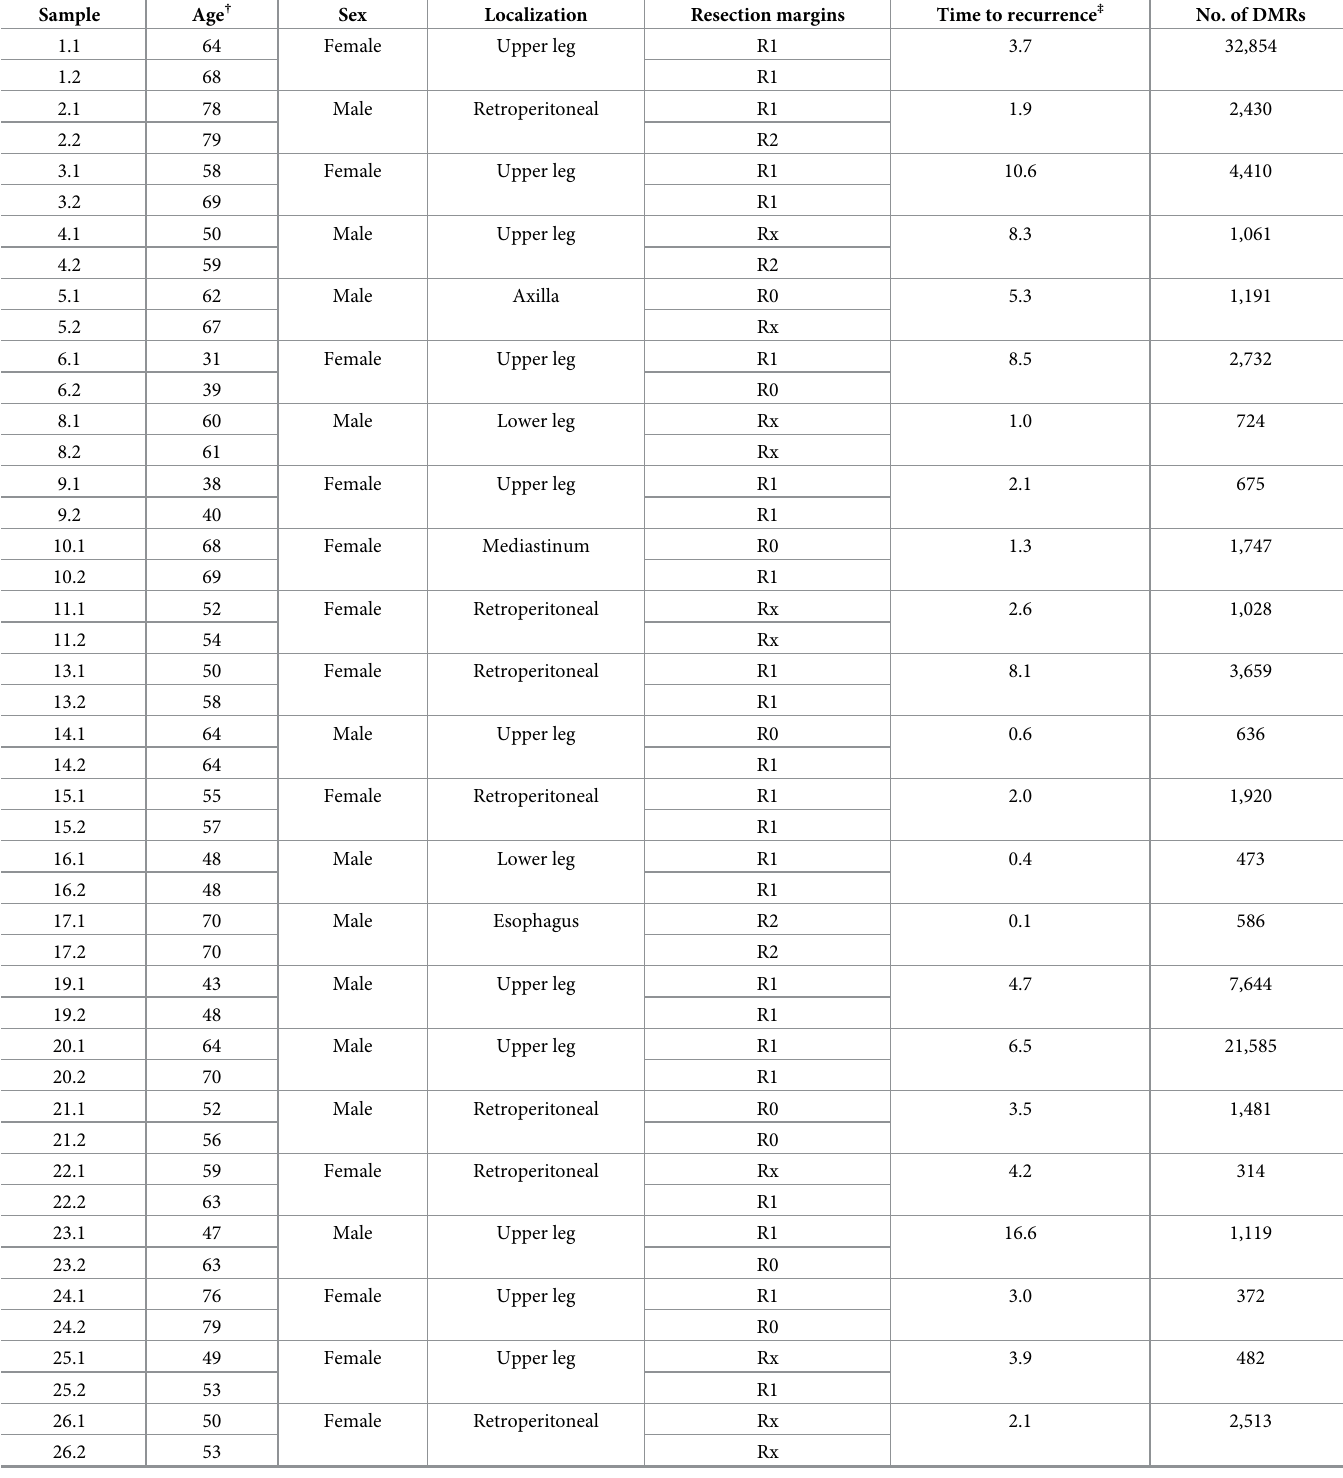
Table 1. Patient and tumor